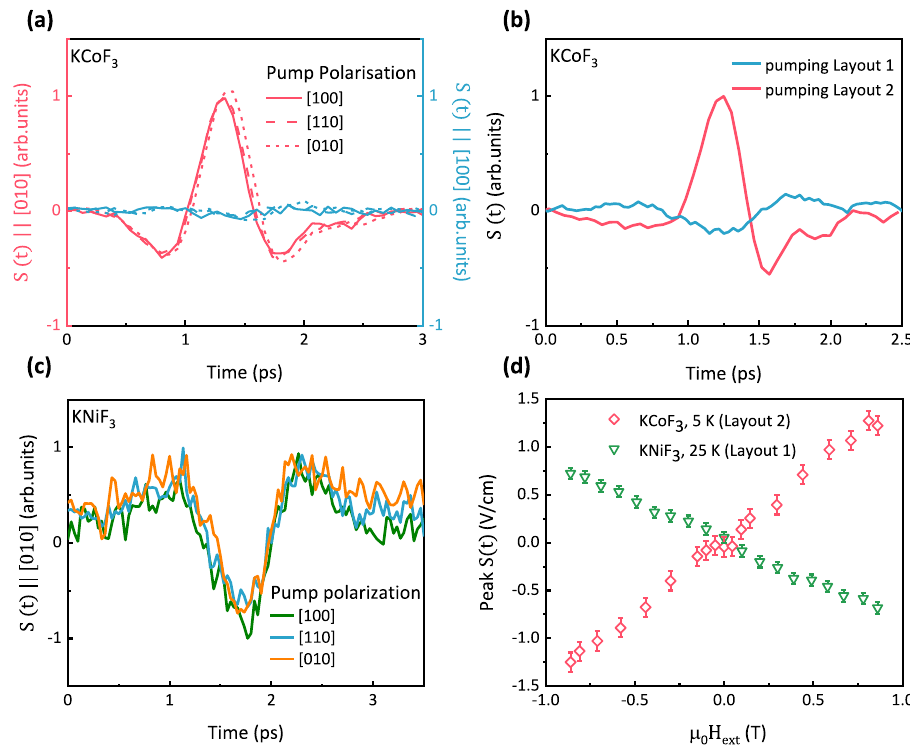
Fig. 2 | Symmetry of the terahertz emission. a Components of the THz emission from KCoF 3 /Pt polarized along the [100]and [010]axes for different optical pump polarizations. The absorbed pump fl uence is 1 : 7 mJ.cm − 2 the ambient temperature is T =20 K and H = + 0 : 85 T along the [100] axis. b THz emission for two pumping geometriesin KCoF 3 /Pt at T =20 K and H = + 0 : 85 T.The different optical paths in